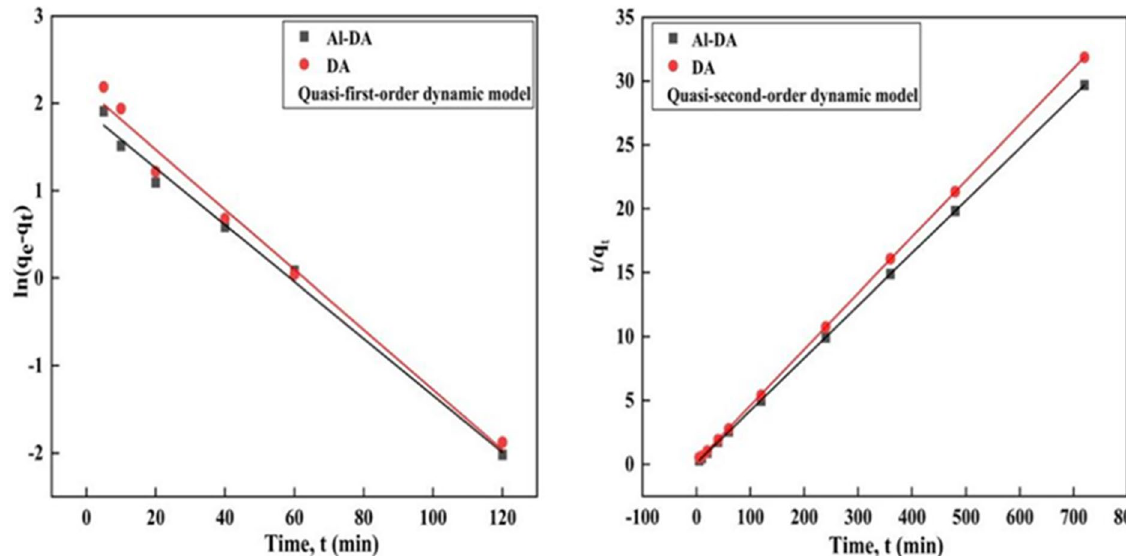
Figure 7. Fitting the experimental data into quasi-first-order and quasi-second-order kinetic equations (fluoride initial concentration is 100 mg/L, Sorbent dose 4 g/L, pH 6, contact time is 2 h).